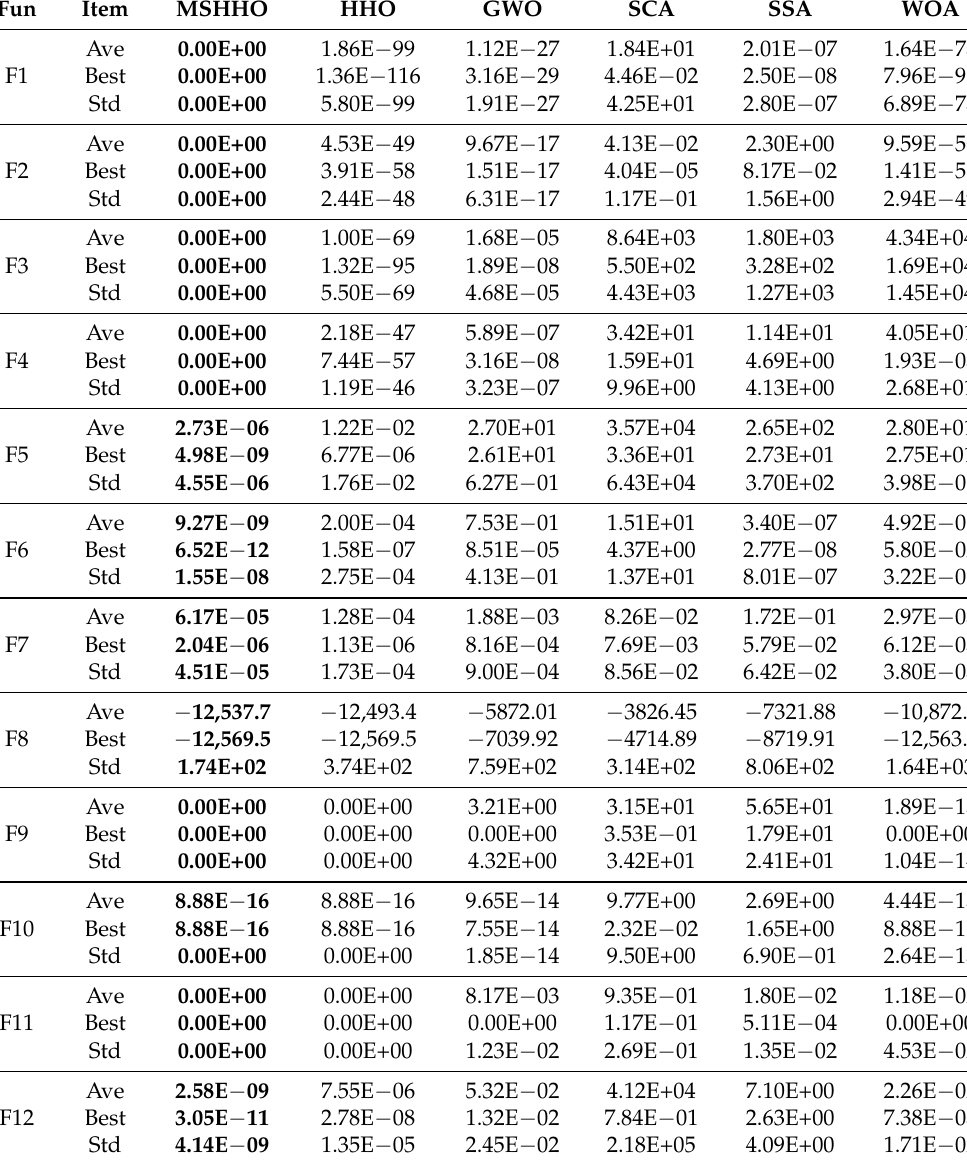
Table 2. Results of CEC2005 benchmark